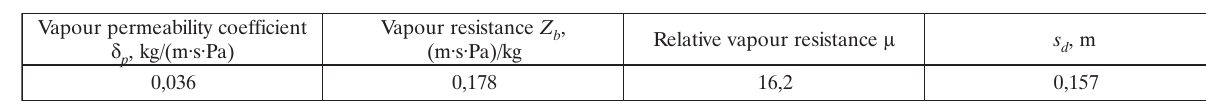
Table 5. Values of the water vapour permeability parameters of the mineral thin